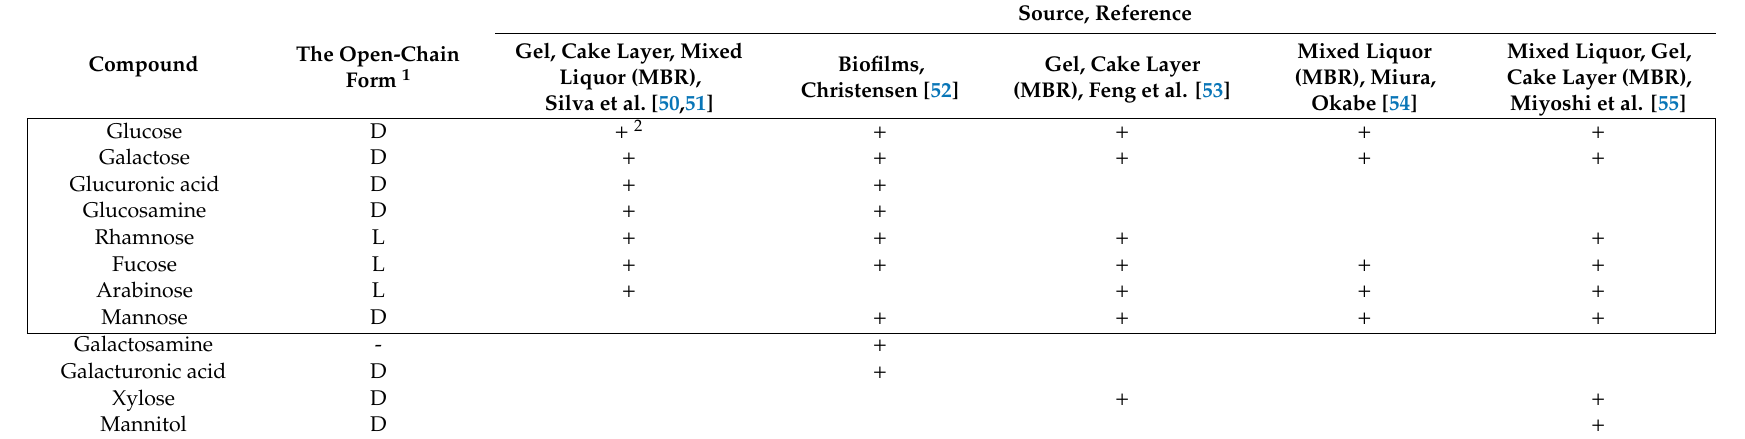
Table 1. Monosaccharides and their derivatives reported in the previous studies. (MBR = membrane bioreactor).